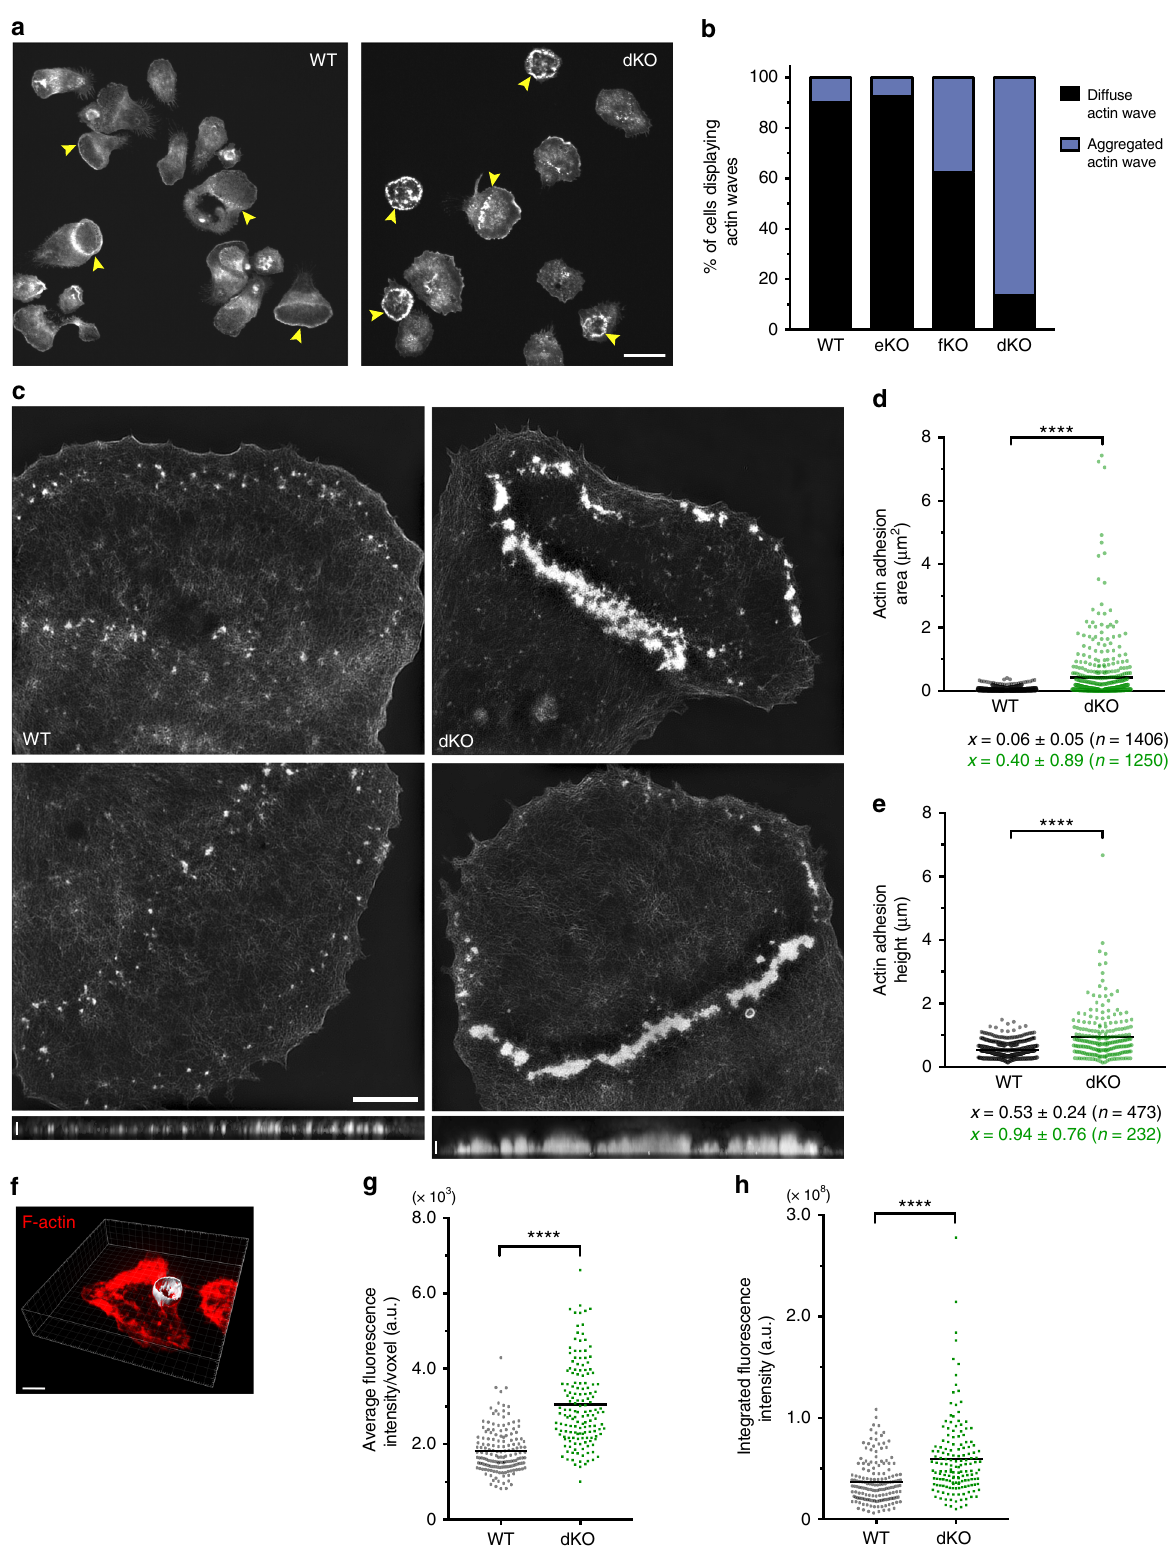
with the punctate actin that makes up the wave (Fig. 3a, b, Supplementary Movie 5). We observed the same localization using primary macrophages, probing for endogenous myo1e (Fig. 3d). While myo1e/f appear to colocalize with actin wave punctae in xy confocal sections, xz projections reveal myo1e/f to